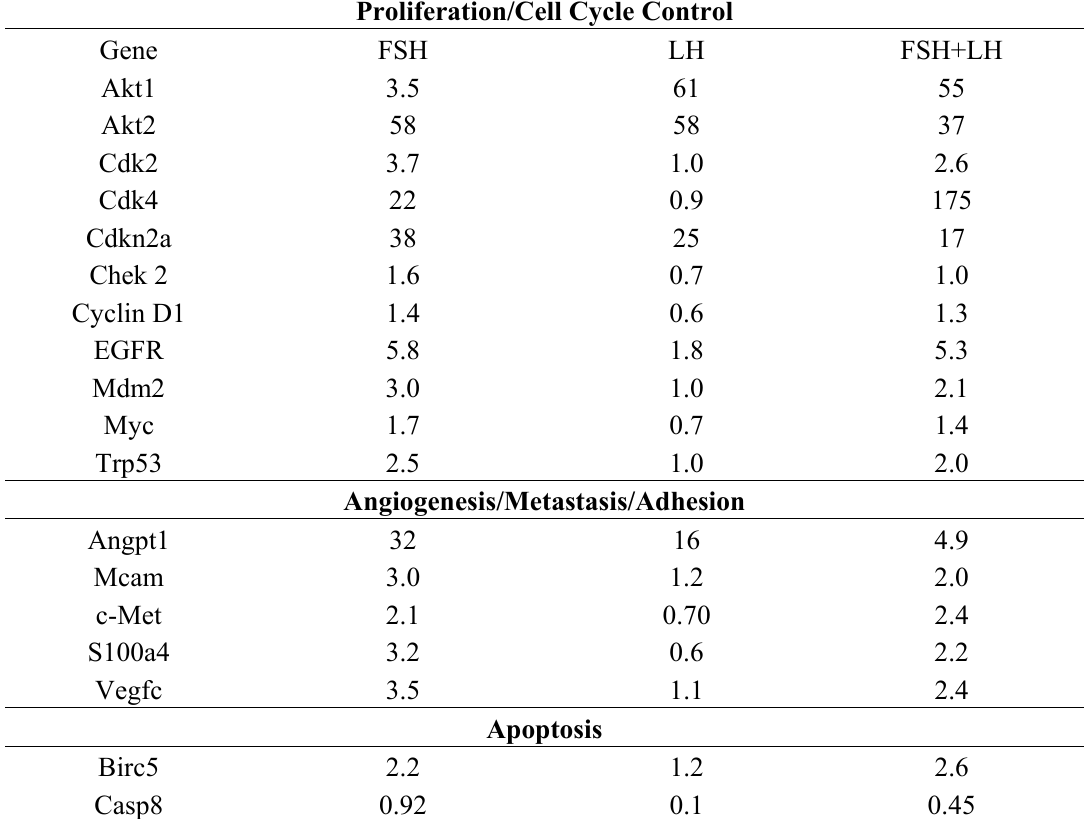
Table 1. Oncogenic pathways modulated by gonadotropins. The OSE from follicle stimulating hormone (FSH), luteinizing hormone (LH) or FSH+LH treated organoids was removed using collagenase and mRNA was isolated. cDNA was reverse transcribed and added to a RT 2 Profiler PCR Mouse Cancer Pathway Finder Array. Numbers represent fold change compared to basal cultured organoids of pathways regulated by the